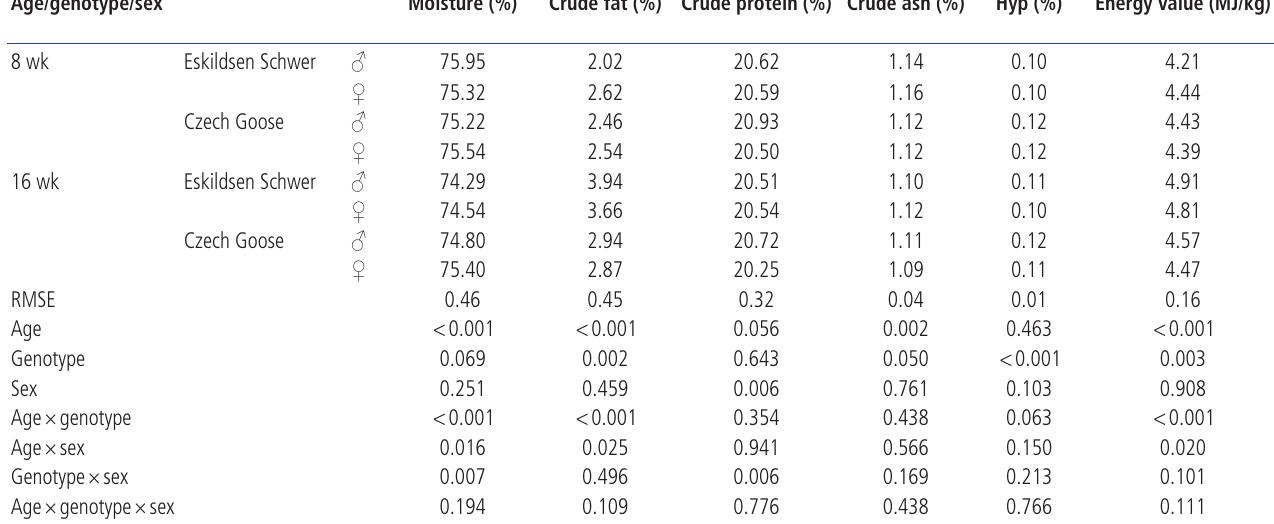
Table 4. Chemical composition of goose meat as affected by age, genotype and sex Age/genotype/sex Moisture (%) Crude fat (%) Crude protein (%) Crude ash (%)